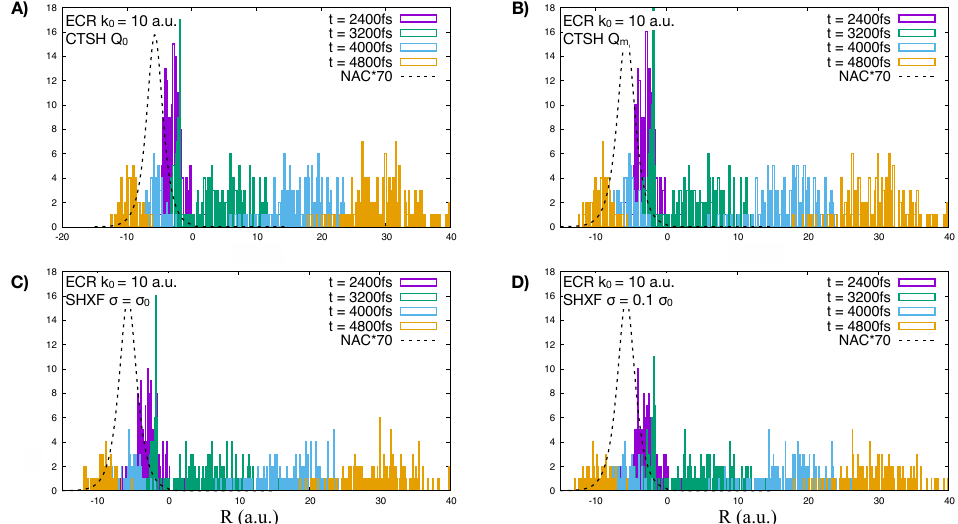
Figure 8. Spatial distribution of trajectories for the ECR k = 10 a.u. model. CTSH with original definition of the QM (panel A ), CTSH with the modified definition of the QM (panel B ), SHXF with σ = σ 0 (panel C ) and SHXF σ = σ 0 /10 (panel D